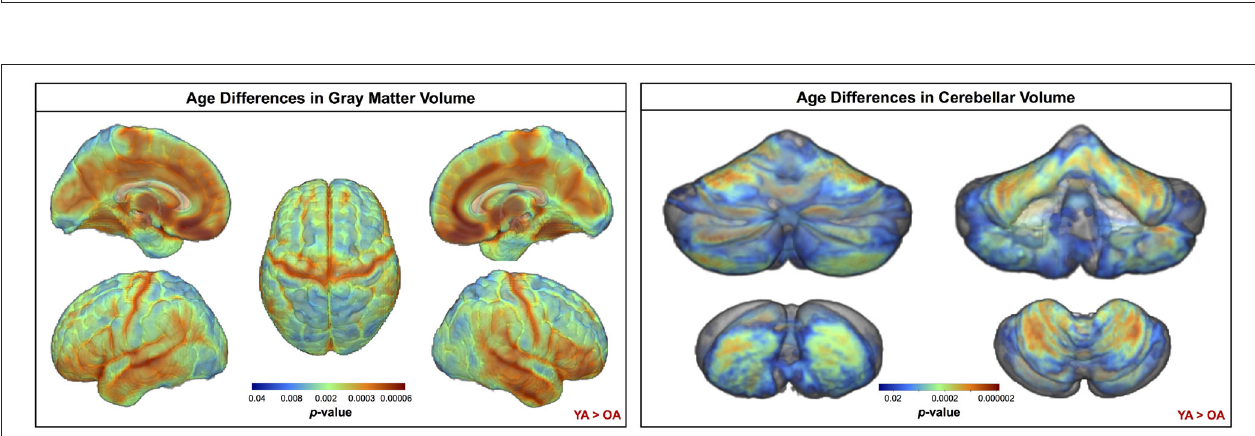
FIGURE 3 | Age differences in gray matter and cerebellar volume. Increasingly warm colors indicate regions where young adult volumes were greater than older adult volumes. Results are overlaid onto a whole brain MNI-space template (left) and onto the SUIT cerebellar template (right). p FWE − corr < 0.05.